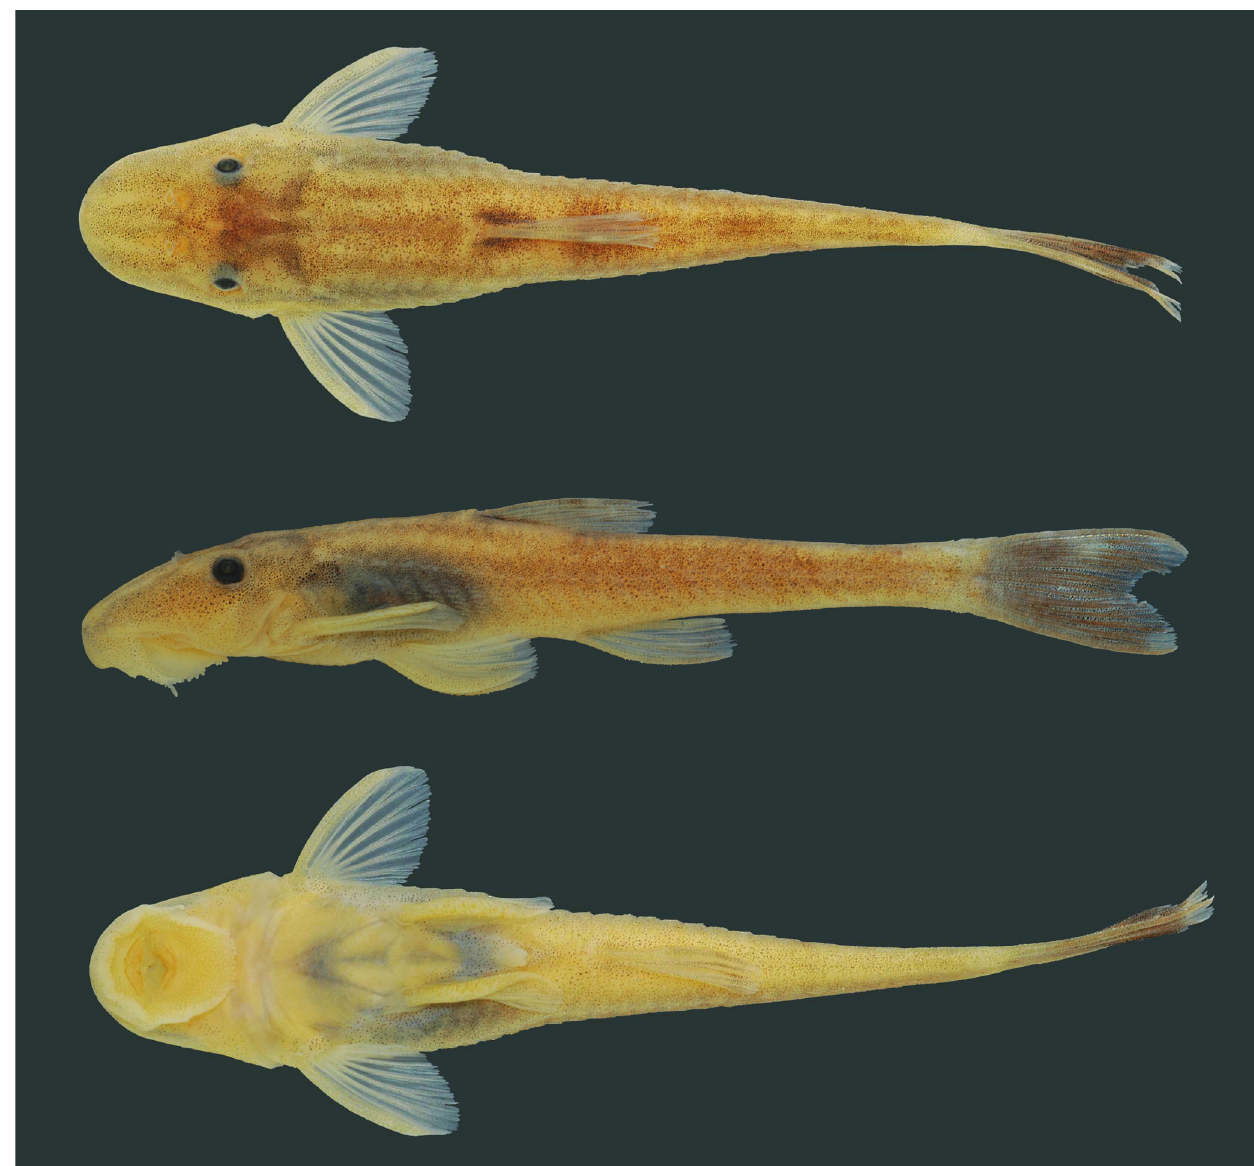
Fig. 6. Rhinolekos schaeferi , holotype, MCP 26939, 35.4 mm SL, male, córrego Fazenda at Chácara Fernanda, rio Paranaíba drainage, Alexânia, Goiás State,